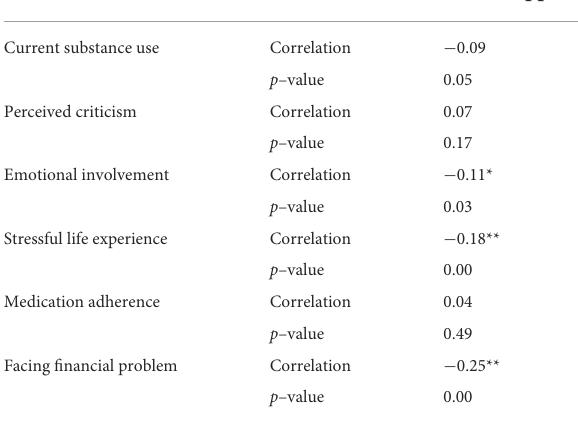
TABLE 5 A correlation of other relapse determinants with social support in patients with schizophrenia at the AMSH, Addis Ababa, Ethiopia ( n =